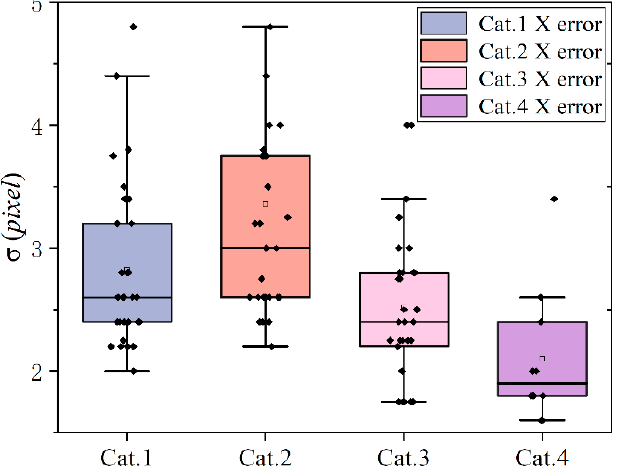
Figure 11. Error evaluation for template matching.